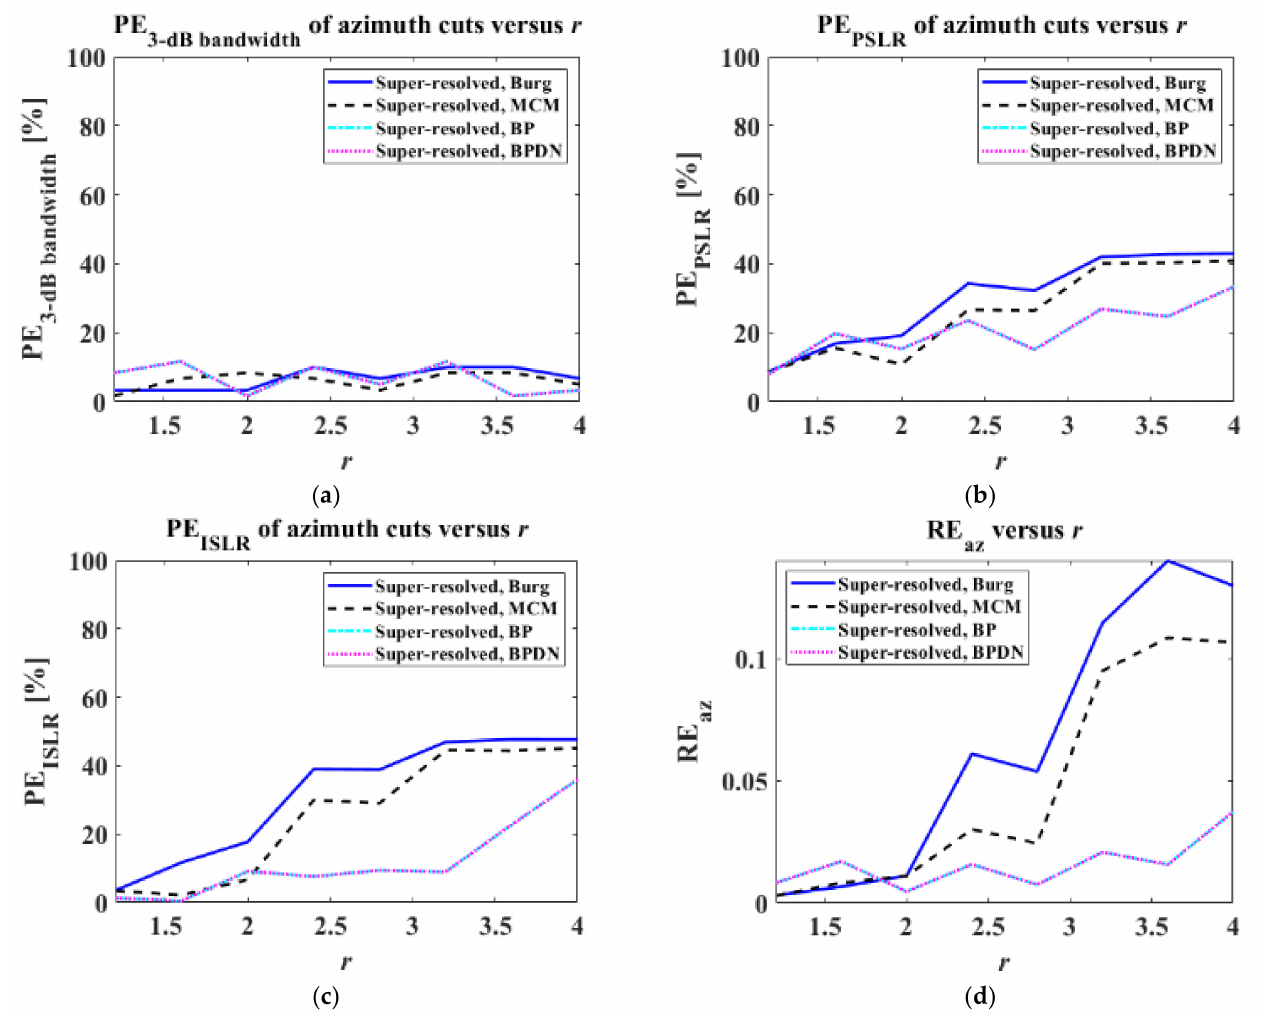
Figure 8. PE 3 − dB bandwidth , PE PSLR , PE ISLR , RE az versus r for azimuth cuts: ( a ) PE 3 − dB bandwidth , ( b ) PE PSLR , ( c ) PE ISLR , ( d ) RE az